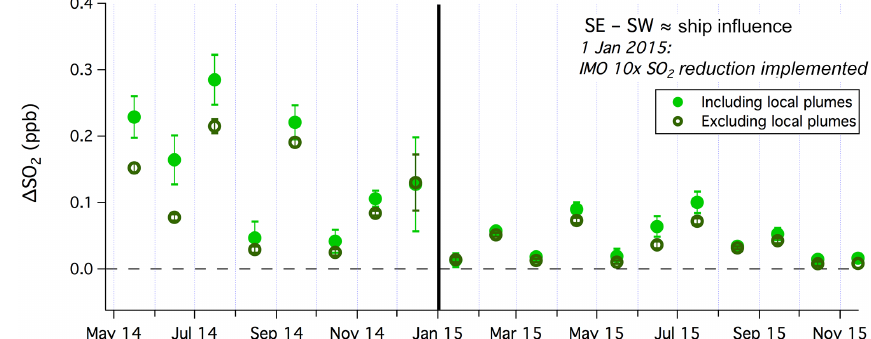
Figure 9. The difference between monthly averaged SO 2 mixing ratios from the southeast and southwest ( (cid:49) SO 2 ) , which we consider to approximately represent ship emissions. (cid:49) SO 2 including and excluding local ship plumes is shown. Error bars are propagated from 2 times the standard errors from each wind sector. Solid vertical line indicates the 1 January 2015 mandate for reduction in ship SO 2